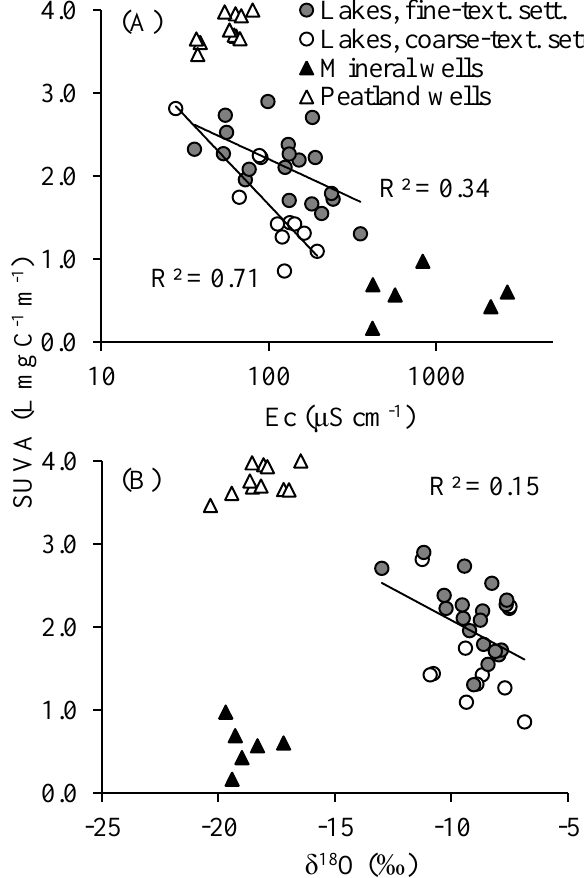
Fig. 7. Variability and relationships between water chemistry and SUVA for lakes and terrestrial sources, (A) Ec and (B) δ 18 O. Only significant ( p < 0.05) relationships are shown with trend lines. Lakes in fine- and coarse-textured settings had differing logarithmic relationships for SUVA/Ec (ANCOVA, F 1 , 26 = 4.45, p = 0.01), while all lakes had a common linear relationship for SUVA/ δ 18 O ( F 1 , 26 = 0.42, p =